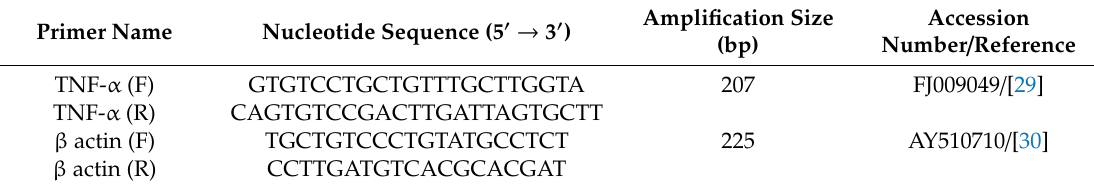
Table 1. Primers used in real-time